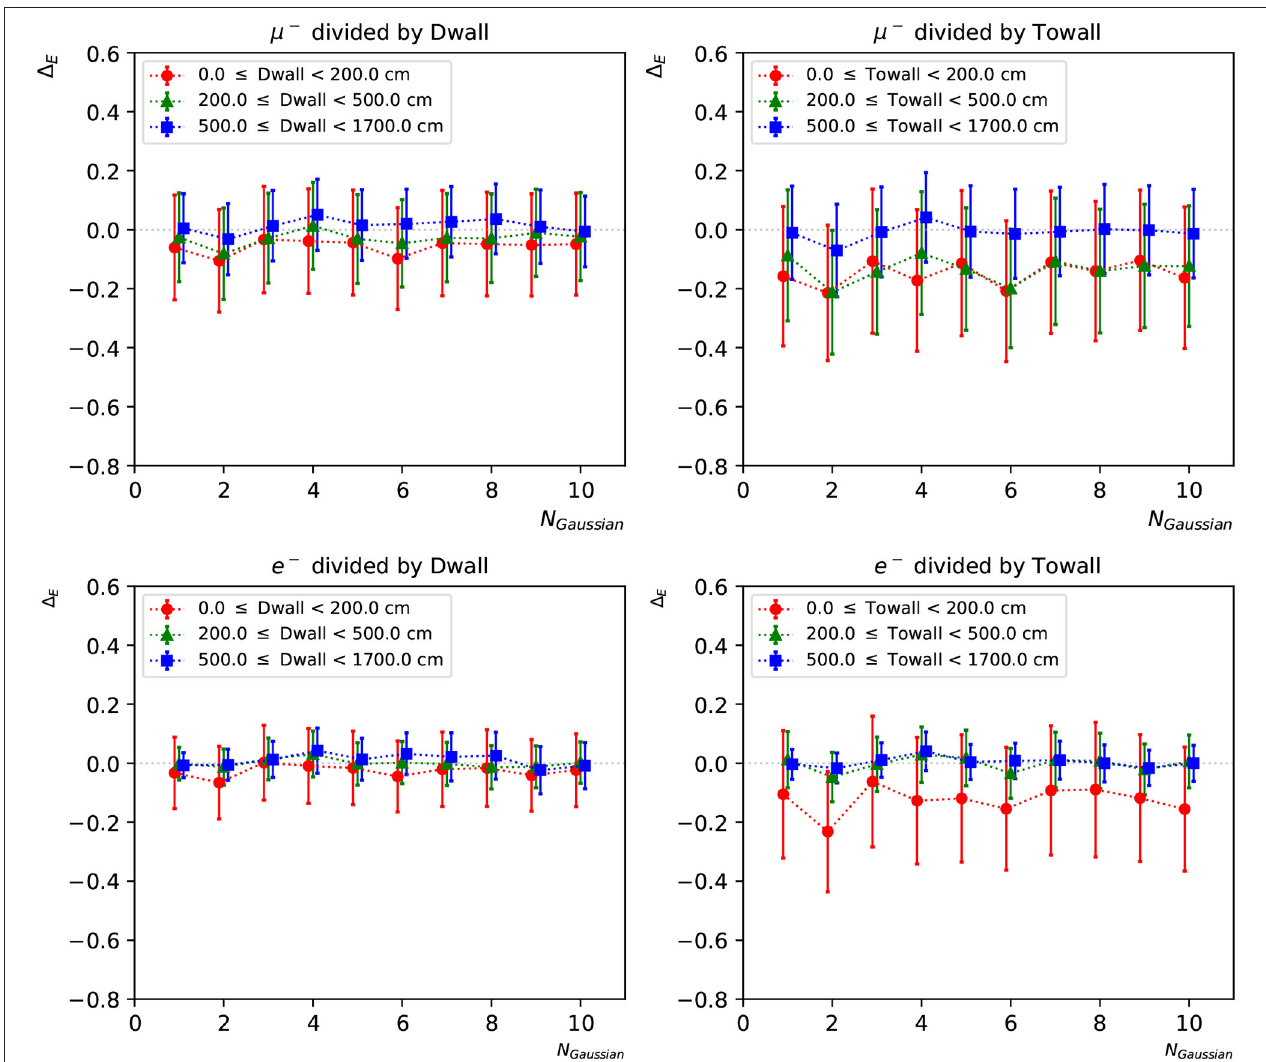
FIGURE 10 | The statistical mean 1 E of charge-time correlated networks with 1 0 200, 200 500, and 500 cm from the detector walls. The left column shows dependence of “dwall” and the right “towall”. Error bars represent the standard ∼ ∼ ≥ deviation of 1 E in each event set, which can be viewed as the energy resolution. loss. A quadruple spline interpolation is applied to the